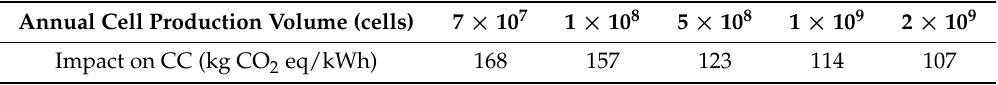
Table 4. GHG emissions of a NCA pack manufactured in Korea in plants of different sizes. CC: climate change.